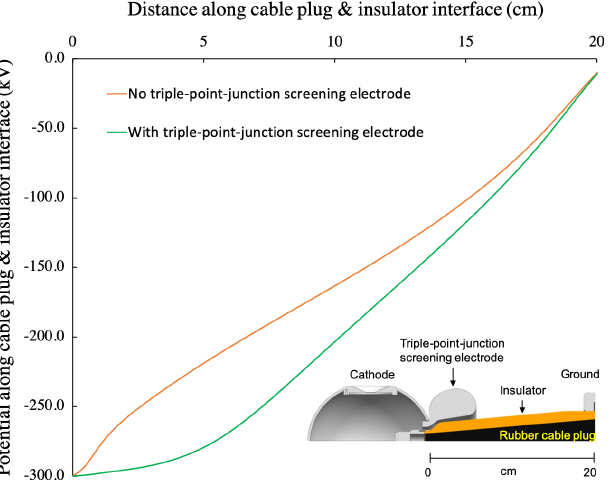
FIG. 7. Electrostatic potential along the interface between the high-voltage-rubber cable plug and the ceramic insulator for cathode electrode biased at − 300 kV. The inset shows a model of the assembly. screening electrode design served to linearize the potential drop along the length of the insulator.